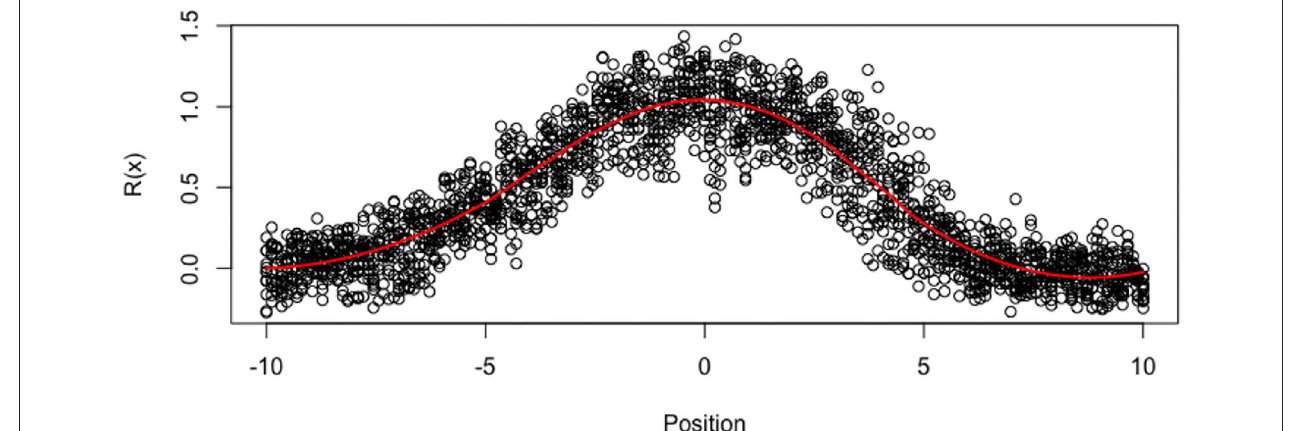
FIGURE 6 | Normalized data y ij for all tubes at all locations. Red line is loess smoother.